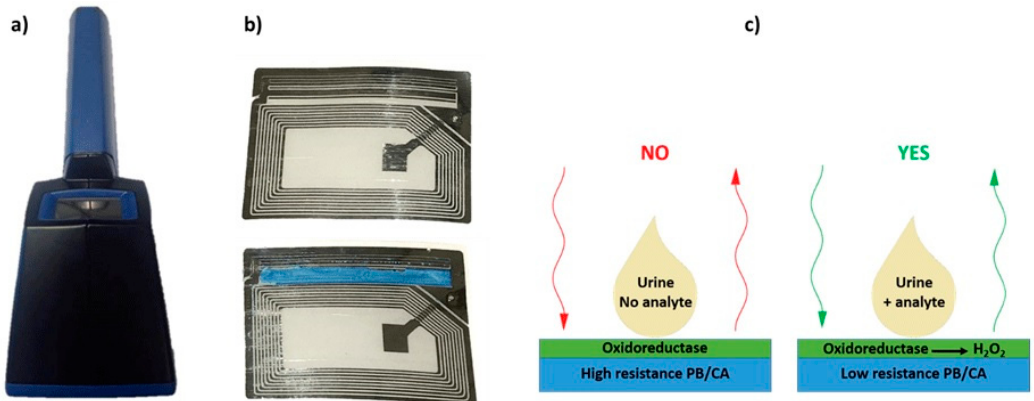
Figure 8. ( a ) Photographs of the portable monitoring unit, ( b ) sensor circuit developed for moisture detection (top) and modified sensor circuit modified with PB / CA layer (bottom), ( c ) Schematics of wireless biosensing. Reproduced from [176] with permission from IEEE.